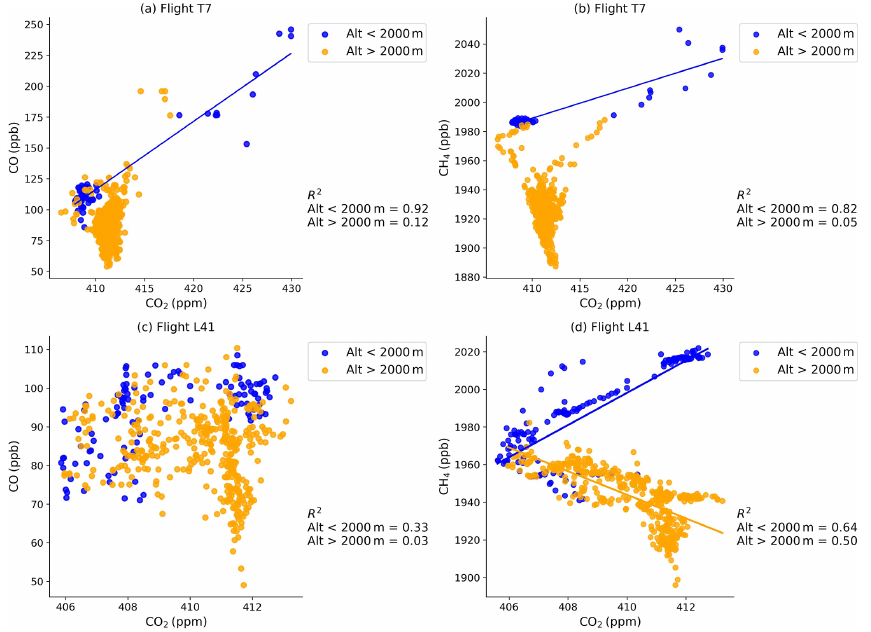
Figure 8. Scatterplots of CO 2 vs. CO (a) and CO 2 vs. CH 4 (b) for flight T7. Same for flight L4.1 in (c) and (d) . Blue dots and respec- tive regression lines are for data acquired under 2000m. Orange dots and respective regression lines are for data acquired above 2000m. Correlation coefficients R 2 are displayed for each